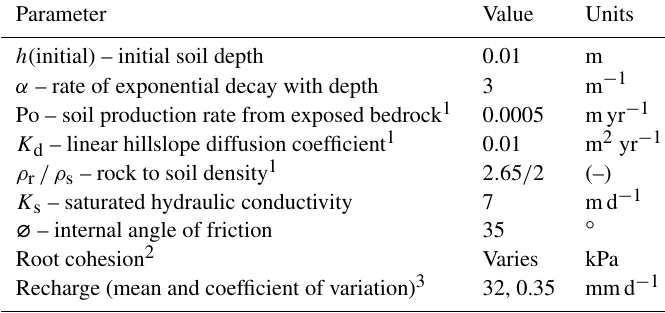
Table 2. Model parameters used in the soil evolution